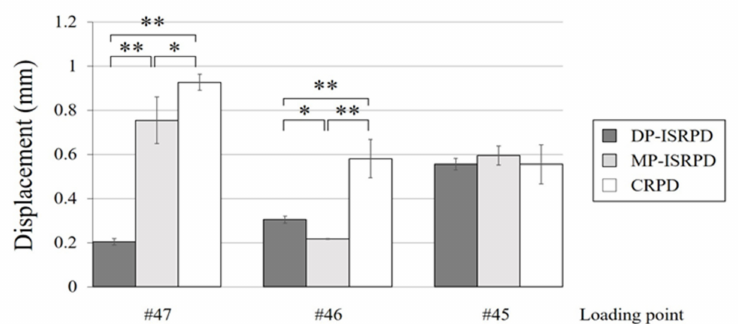
Figure 4. Vertical displacement (mm) of denture base under each loading point (#45, #46 and #47) in conventional removable partial denture (CRPD), mesially positioned implant-supported removable partial denture (MP-ISRPD) and distally positioned implant-supported removable partial denture (DP- ISRPD). Error bars represent the standard deviation, and statistical analyses are described as * p < 0.05 and ** p < 0.01, analysis of variance (ANOVA) with Tukey Honestly Significant Difference (HSD).